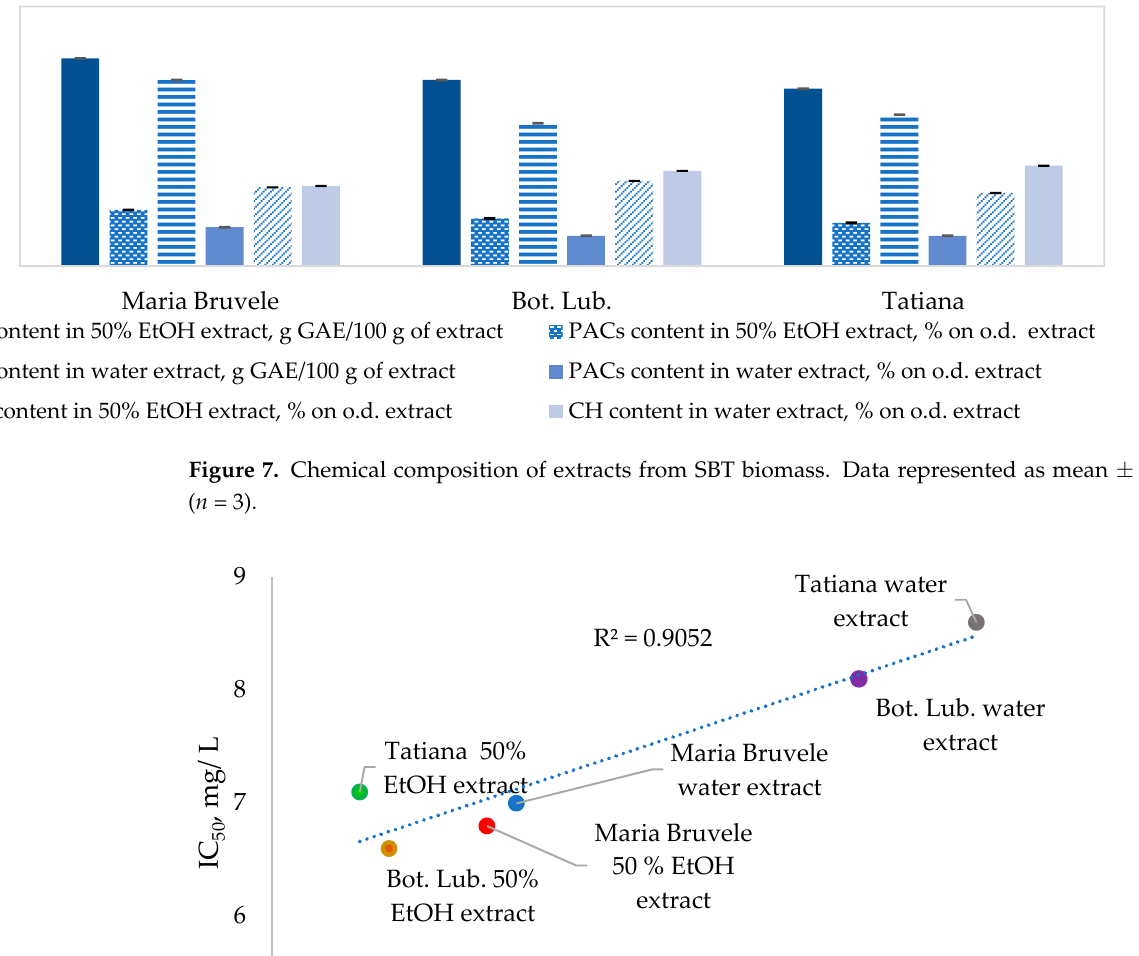
Figure 7. Chemical composition of extracts from SBT biomass. Data represented as mean ± SD ( n = 3).